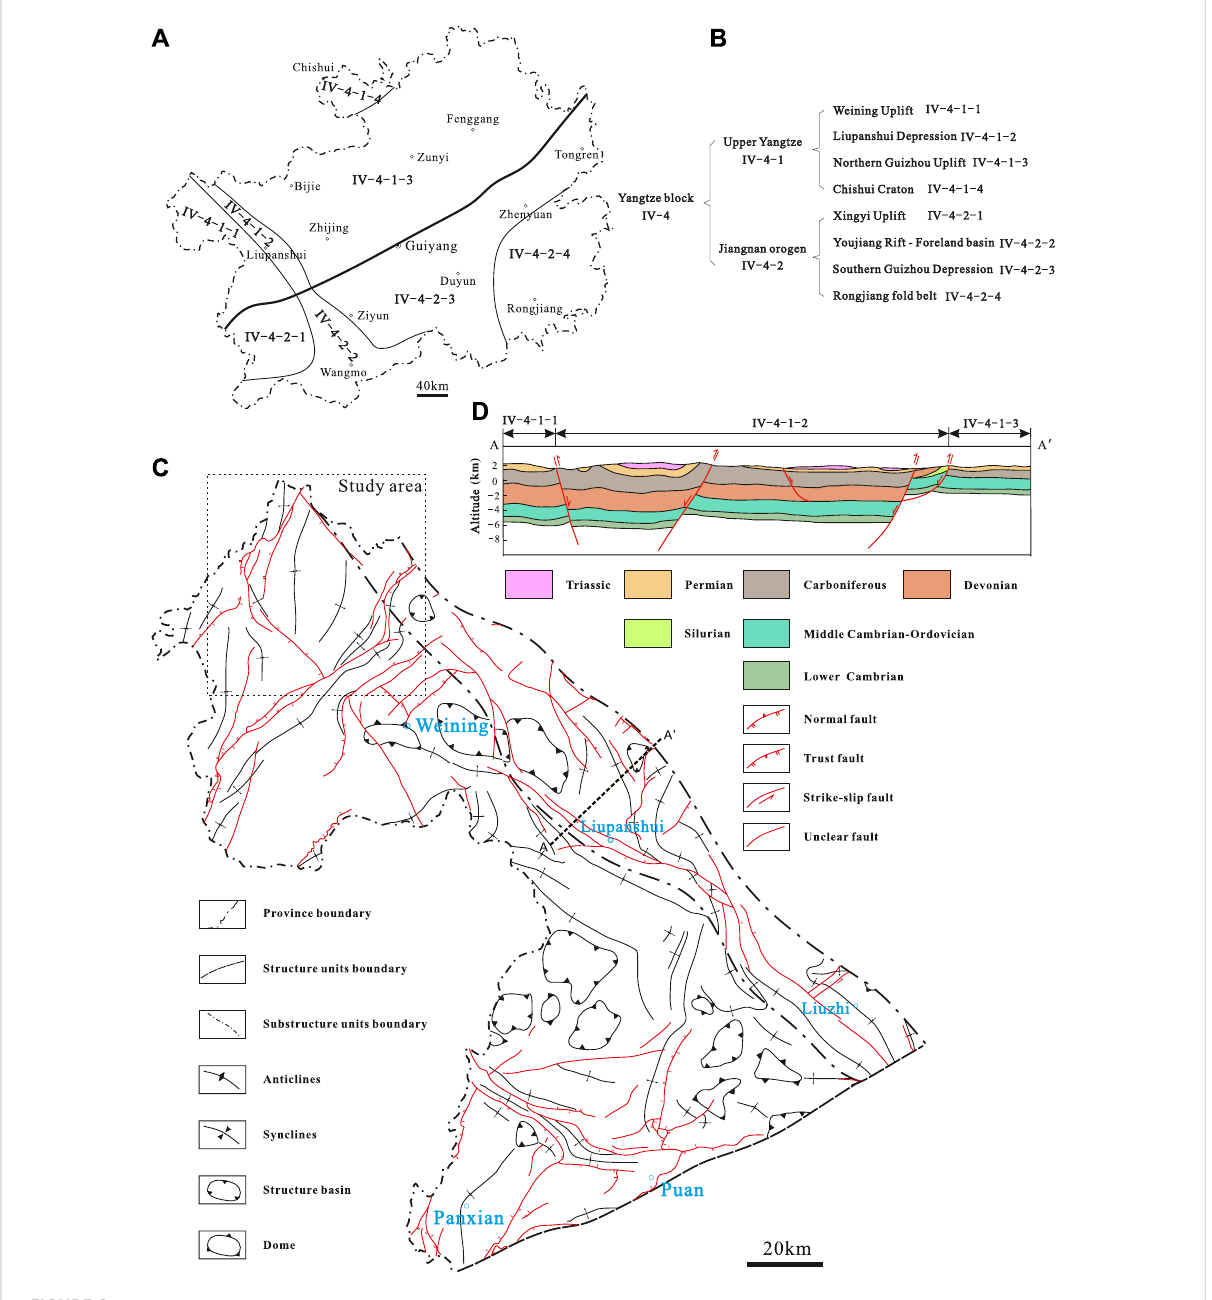
FIGURE 2 Structural outline of the northwestern Guizhou Province. (A) The distribution of tectonic units in Guizhou Province. (B) Name of each tectonic unit in A. (C) The present-day structure outline of the Weining Uplift and of the Liupanshui Depression. (D) Geological interpretation of magnetotelluric inversion pro fi les of continuum media across the Liupanshui Depression (Wang et al.,